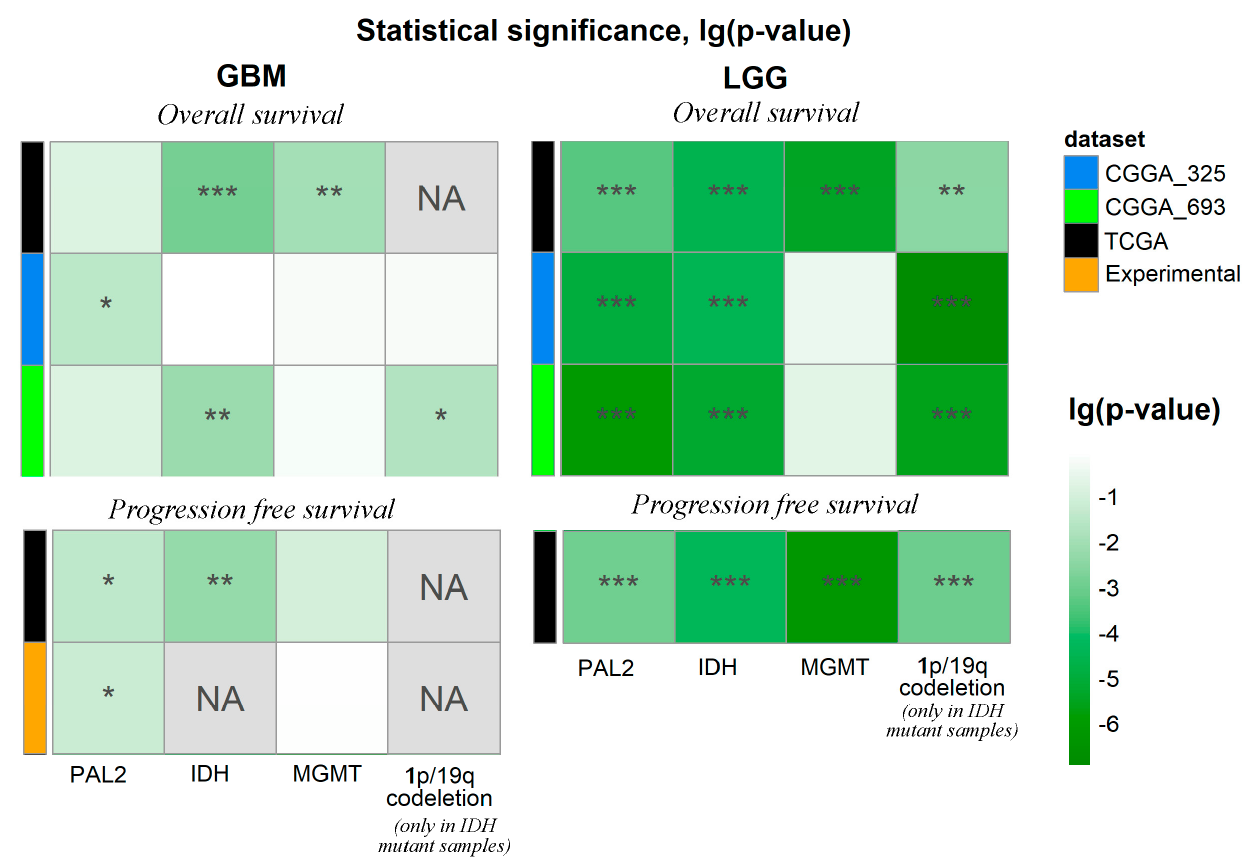
Figure 5. Performance of FREM2 pathway PAL2 survival biomarker in glioma datasets in comparison with IDH mutation, MGMT methylation, and 1p/19q statuses. 1p/19q statuses were assessed only for IDH mutant tumors. p -values of log-rank test of using FREM PAL2, IDH mutation, and MGMT methylation statuses were investigated as survival predictors in 9 comparisons. * stands for p < 0.05, ** for p < 0.01, *** for p < 0.001. Color markers indicate the dataset under analysis. IDH mutation status was used for the full cohort, including samples with non-codeletion and 1p/19q-codeletion statuses.